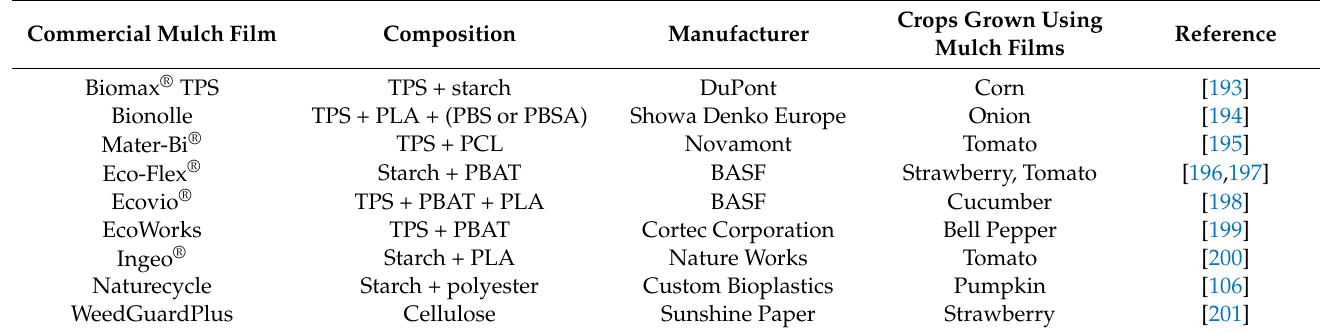
Table 3. Some commercially available mulch films and the crops grown using